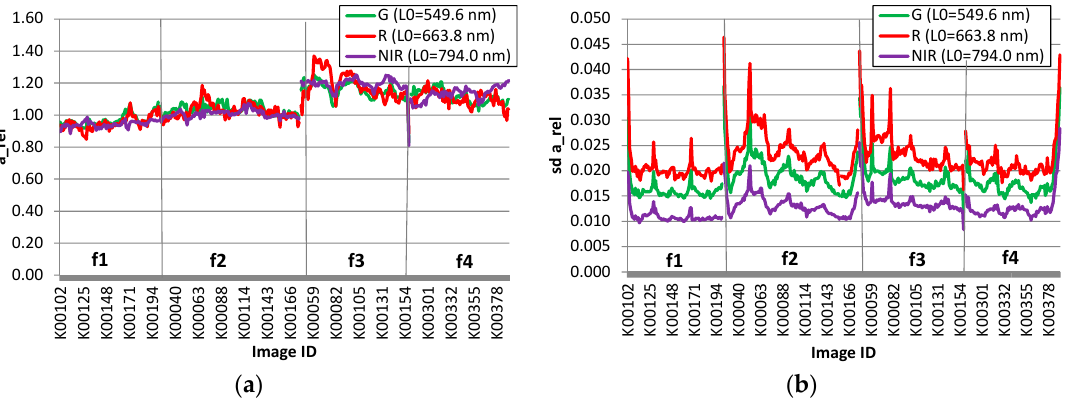
Figure 11. ( a ) Estimated (cid:1853) (cid:3045)(cid:3032)(cid:3039) parameters and ( b ) their a posteriori standard deviations for green (L0 = 549.6 nm), red (L0 = 663.8 nm) and NIR (L0 = 794.0 nm) bands.